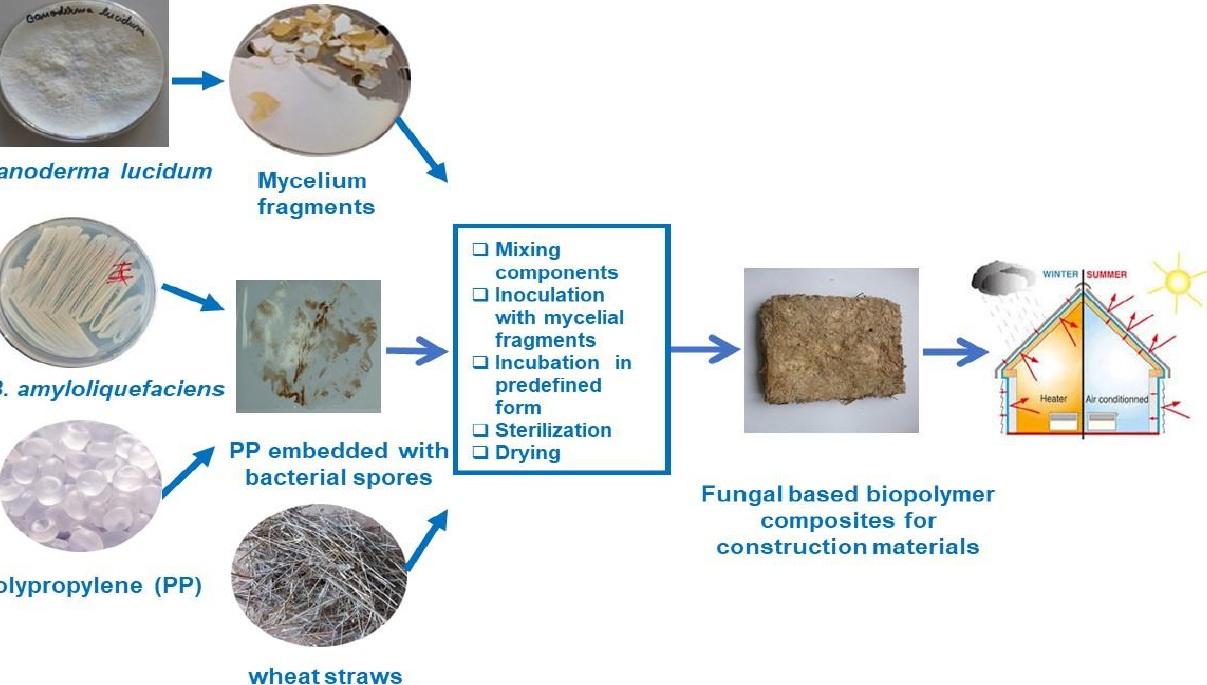
Figure 4. Schematic representation for preparation of fungal composite material.